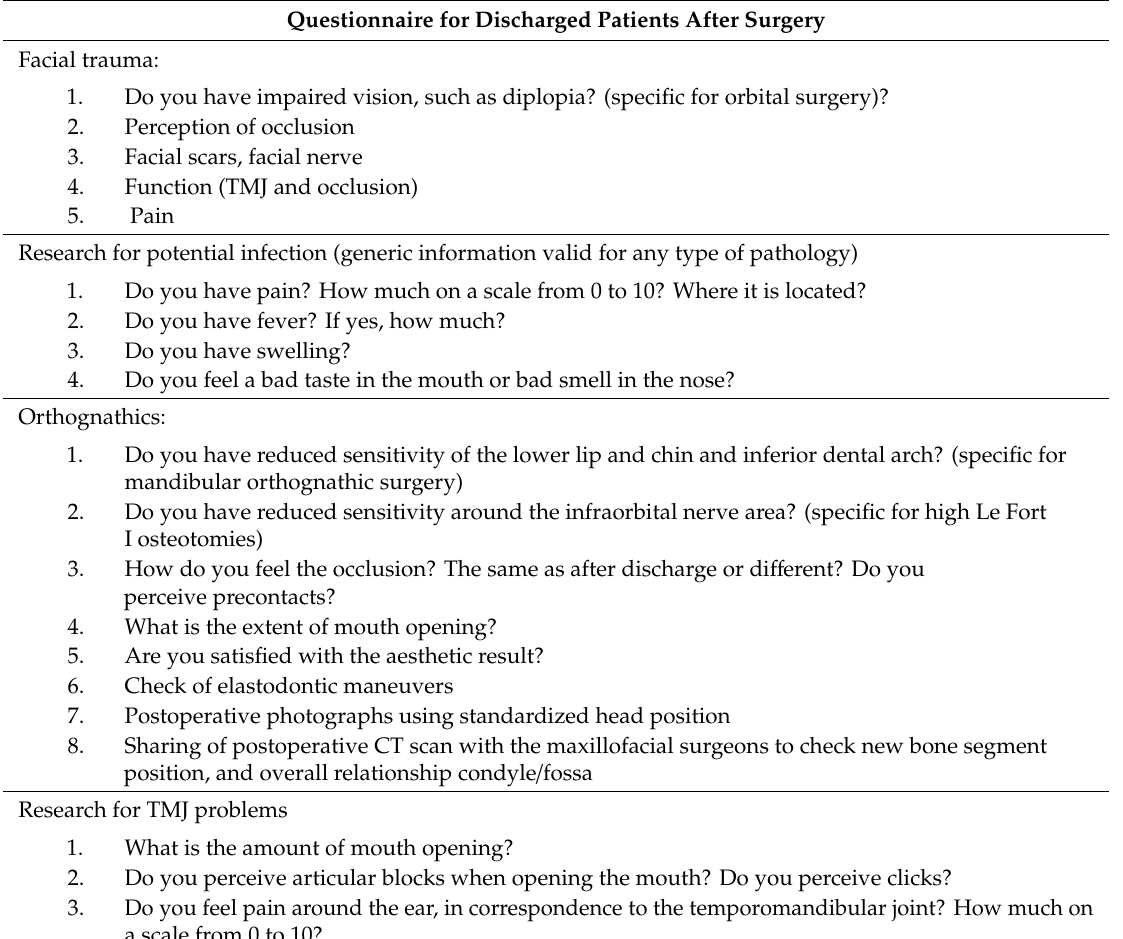
Table 1. “Telesemeiology checklist” with items for